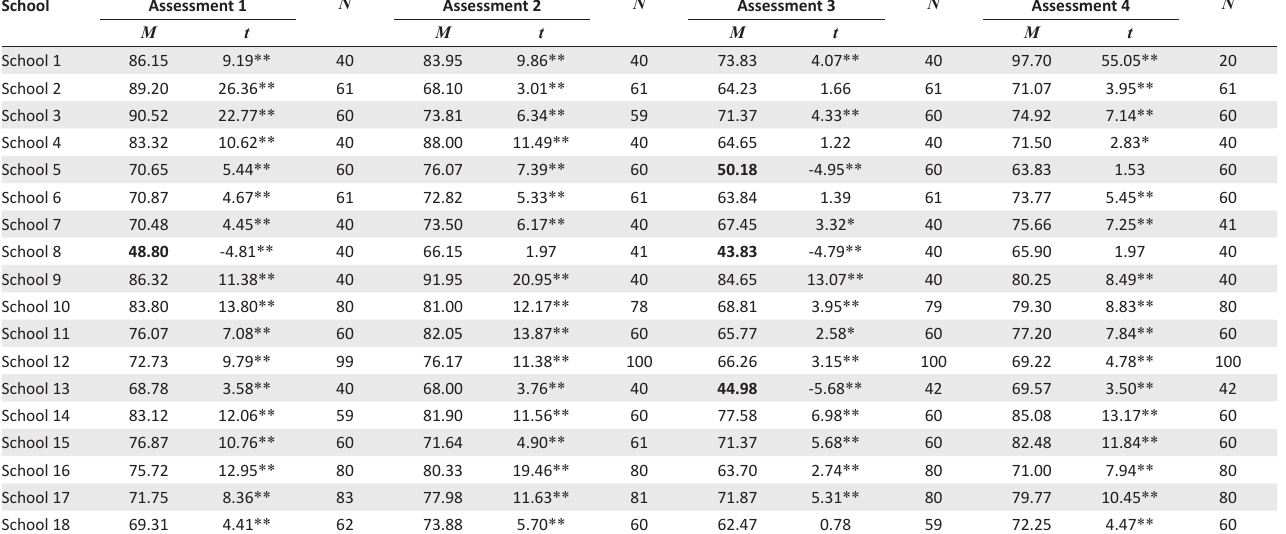
TABLE 3: School performance against Living through Learning performance standard (60 % ).